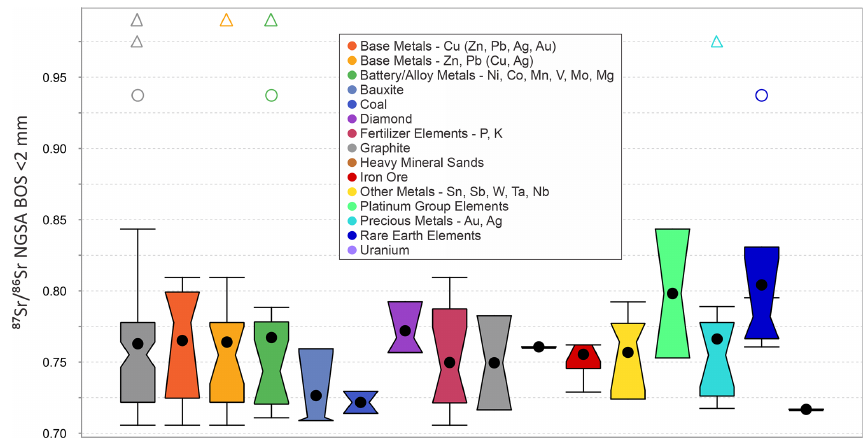
Figure 7. Distribution of the 87 Sr / 86 Sr data from the northern Australia Sr isotope study area by mineral occurrence hosted in same catchment. The categories shown, from left to right, are as follows: all ( n = 97); Base Metals – Cu (Zn, Pb, Ag, Au) ( n = 5); Base Metals – Zn, Pb (Cu, Ag) ( n = 19); Battery/Alloy Metals – Ni, Co, Mn, V, Mo, Mg ( n = 17); Bauxite ( n = 3); Coal ( n = 2); Diamond ( n =